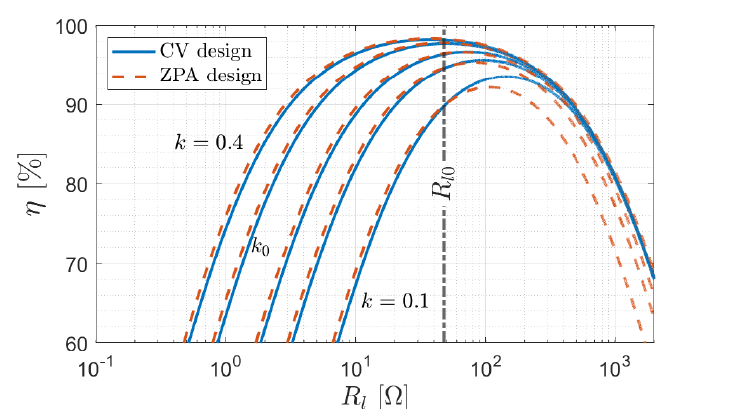
Figure 7. Overall link efficiency of a WPT system designed for CV or coupling independent ZPA, operating at f 0 , as a function of the receiver equivalent load R l , for different coupling coefficients k